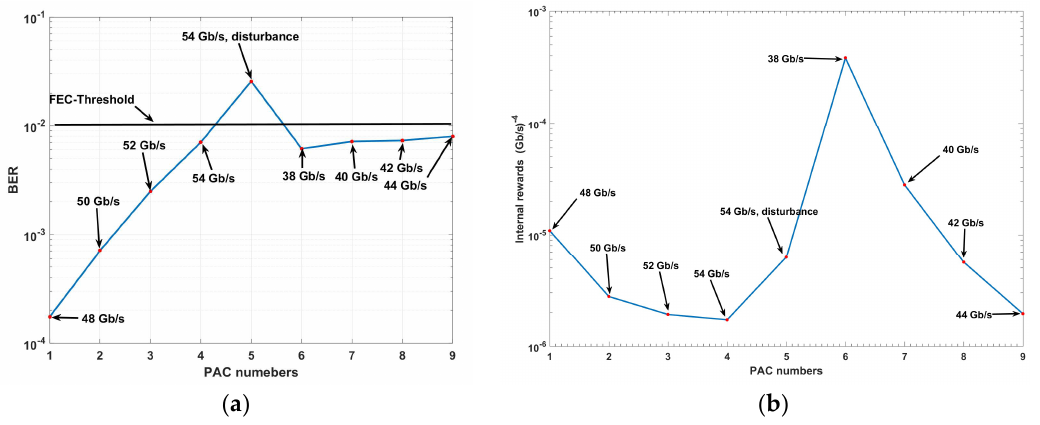
Figure 19. The simulation results for the cognitive dynamic system (CDS) in presence of disturbance ( a ) bit error rate (BER) vs perception action cycle (PAC) numbers, ( b ) CDS learning curve.